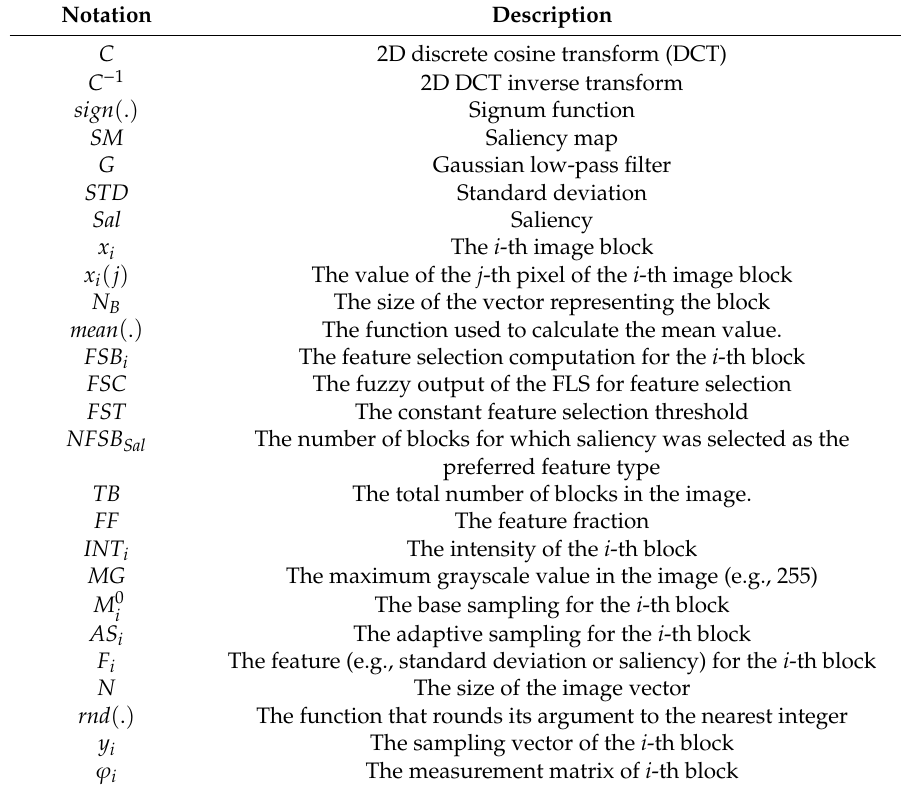
Table 1. The overall notations used in this